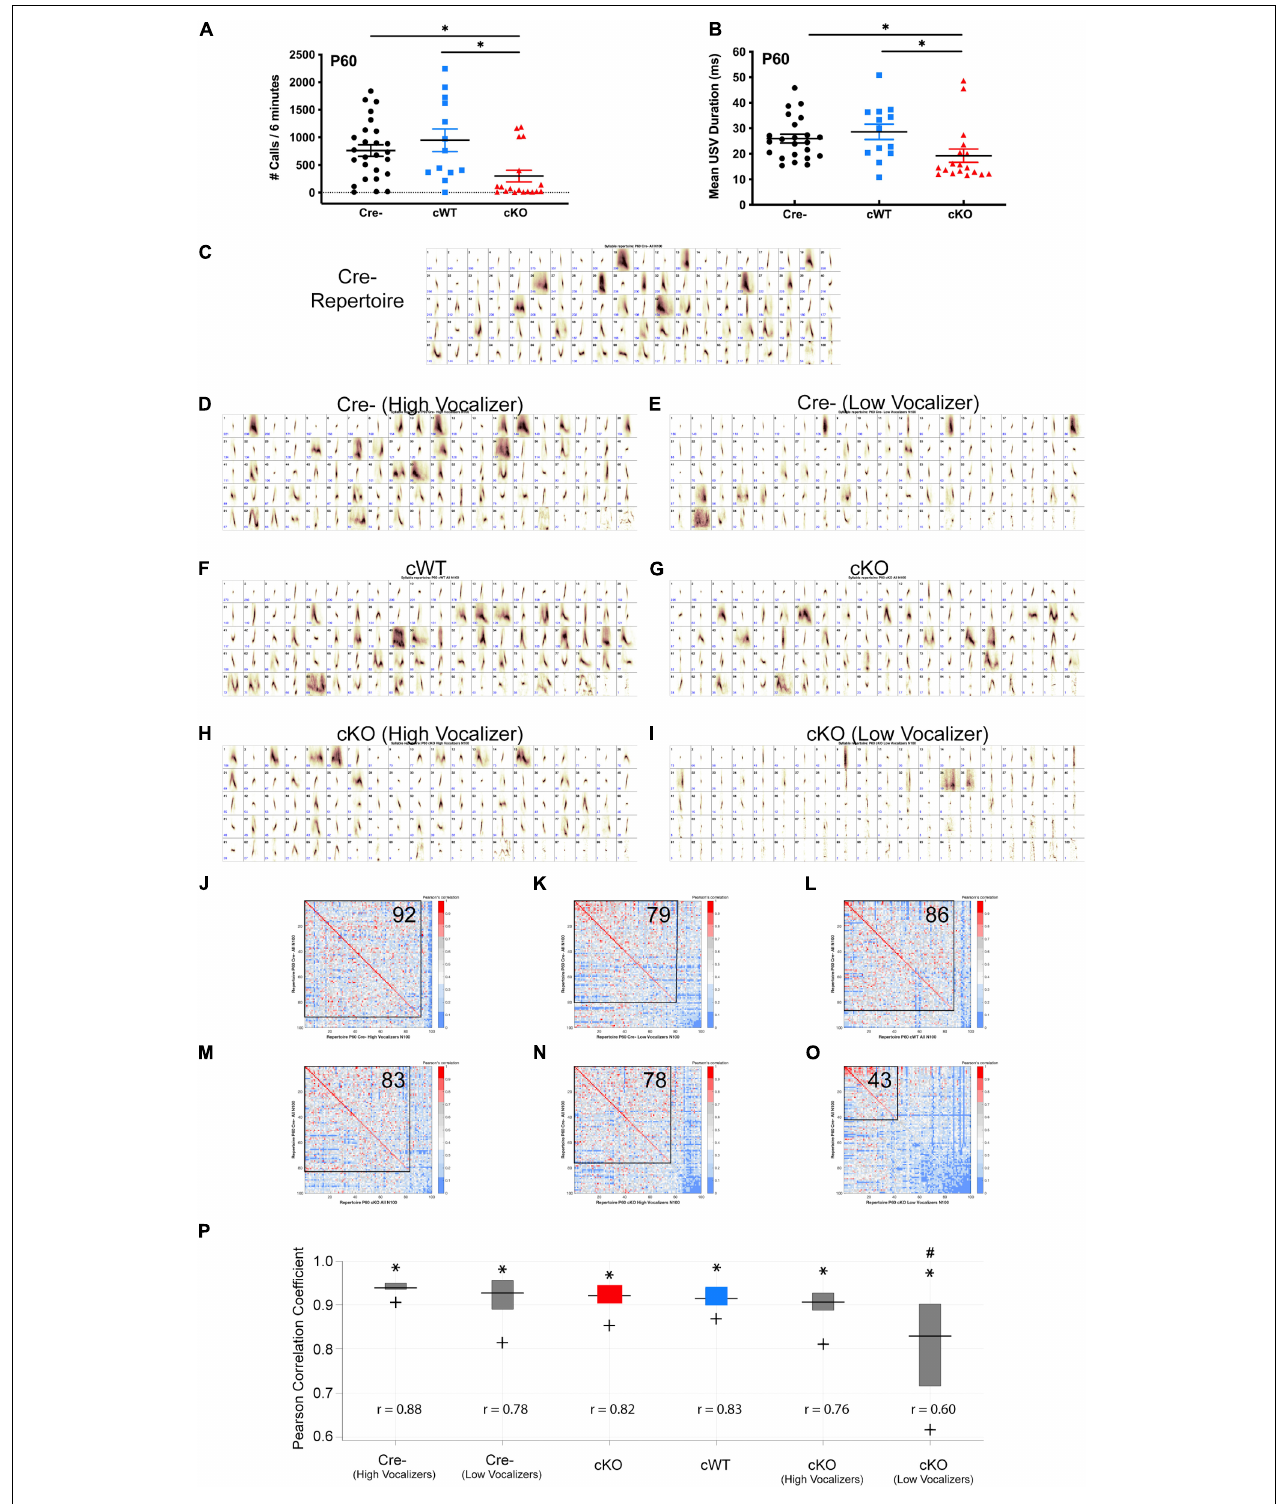
FIGURE 2 | Sustained vocalization deficits in Met cKO adult mice. (A) Quantification of the number of USVs produced by P60 males paired with females over a 6-min recording period during a direct social interaction task. n = 26 Cre-, 13 cWT, 18 cKO. “ ∗ ” indicates p < 0.05 as analyzed by non-parametric Kruskal-Wallis test and Dunn’s test to correct for multiple comparisons. (B) Quantification of the duration of USVs made by P60 males over the 6-min recording period. n = 26 Cre-,